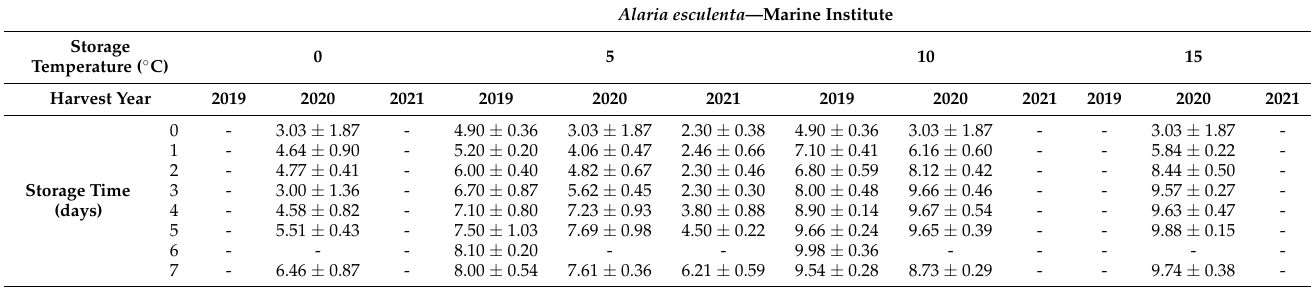
Table 2. Microbial population in seaweed harvested in 2019, 2020 and 2021 from the Marine Institute (Ireland) and stored under different temperature conditions.